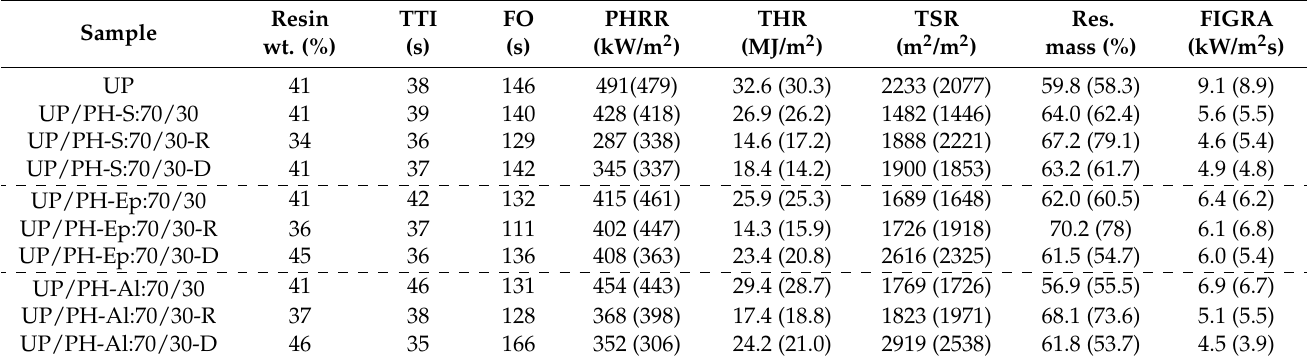
Table 2. Cone results for GFRC of UP and UP/PH blends with and without FRs exposed to 50 kW/m 2 heat flux.